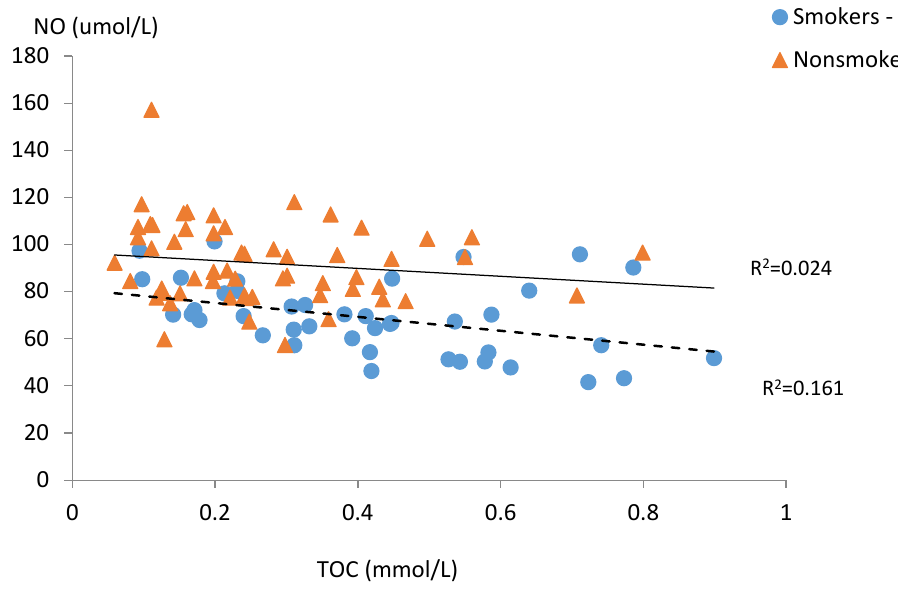
Figure 2. Correlations between serum NO and TOC levels in the subgroups of smoking (n = 42) and non-smoking pregnant women (n = 57).